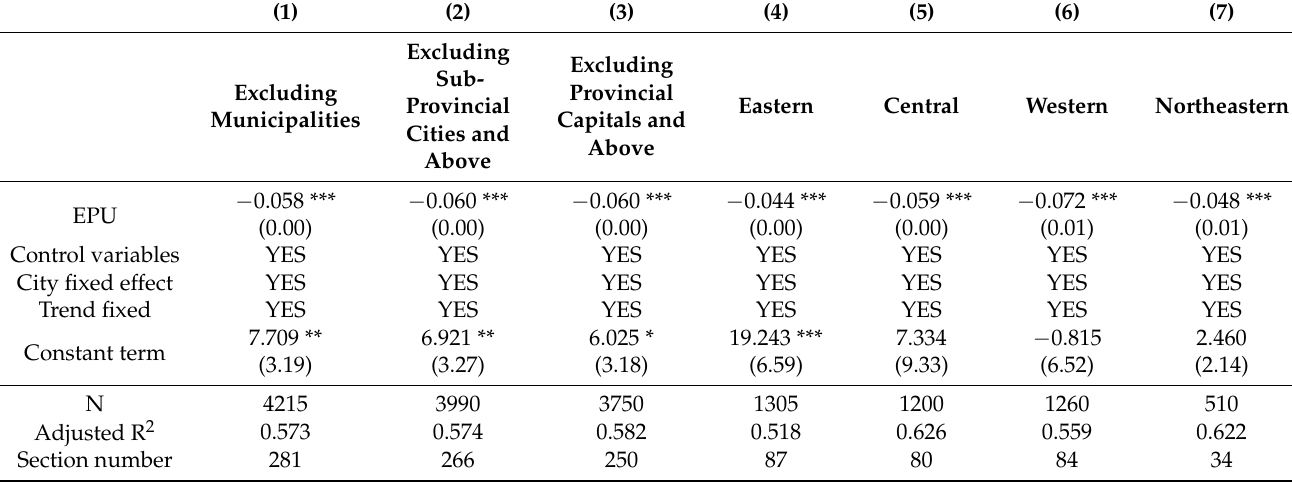
Table 4. Inspection of different samples and